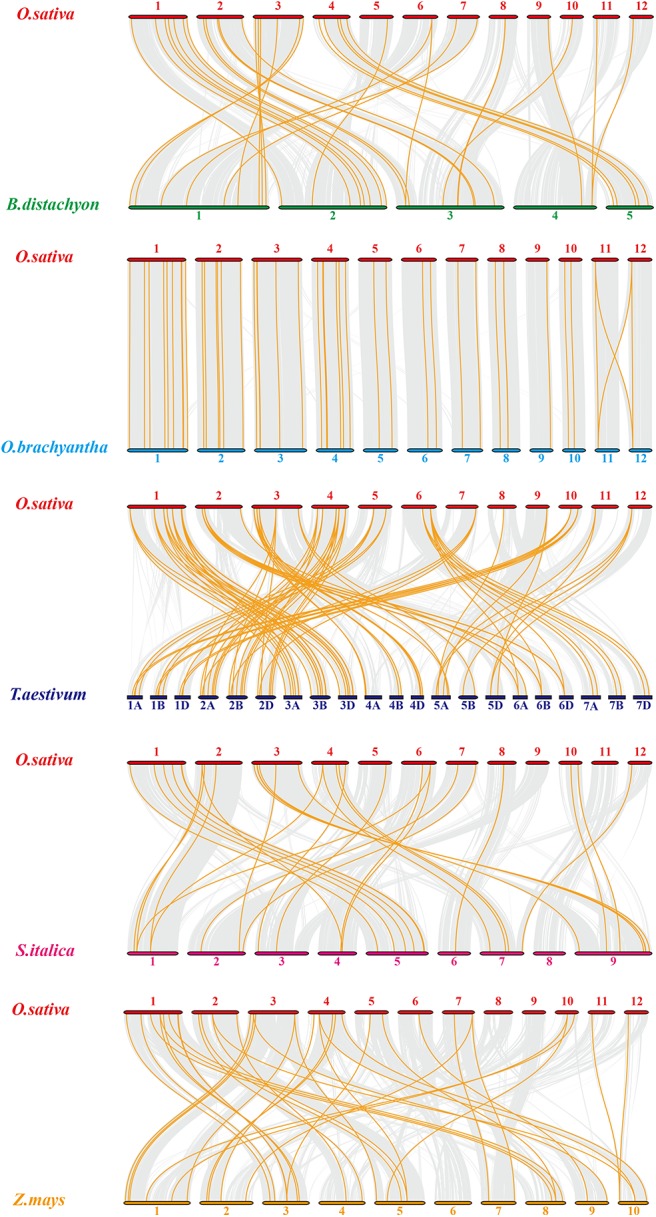
Synteny analysis of heavy-metal-associated genes between rice and Brachypodium distachyon, Oryza brachyantha, Triticum aestivum, Setaria italica, and Zea mays. Gray lines in the background indicate the collinear blocks within rice and other plant genomes, while the orange lines highlight the syntenic OsHMP gene pairs. The species names with the prefixes “O. sativa,” “B. distachyon,” “O. brachyantha,” “T. aestivum,” “Setaria italica,” and “Z. mays” indicate Oryza sativa, Brachypodium distachyon, Oryza brachyantha, Triticum aestivum, Setaria italica, and Zea mays, respectively. Different color bars represent the chromosomes of different species. The chromosome number is labeled at the top or bottom of each chromosome.